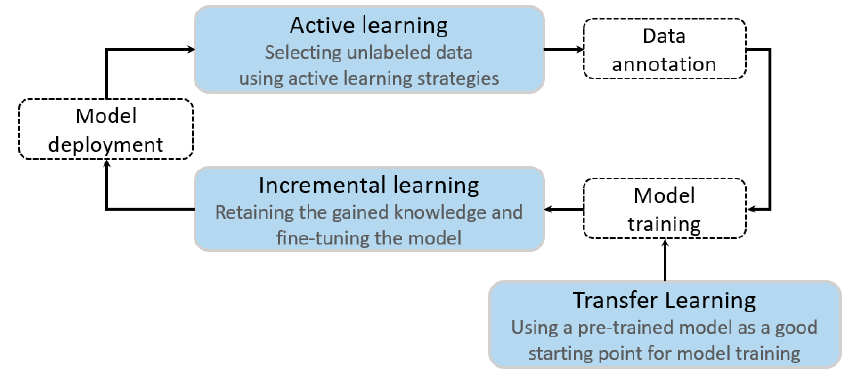
Figure 1. The interrelations between AL, IL, and TL.